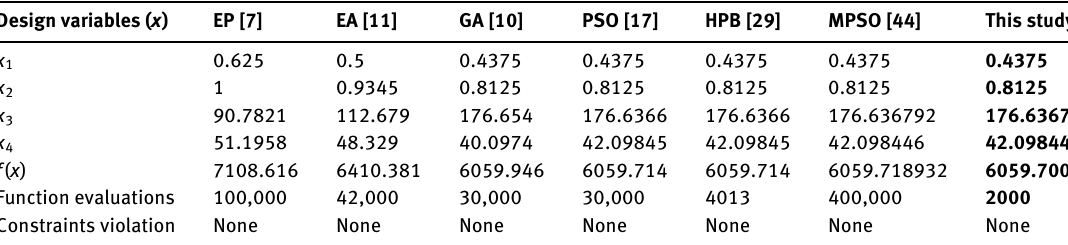
Figure 5: Convergence of Best and Mean Values of Objective Function for Pressure Vessel Design. Table 2: Optimum Solutions for the Design of Pressure